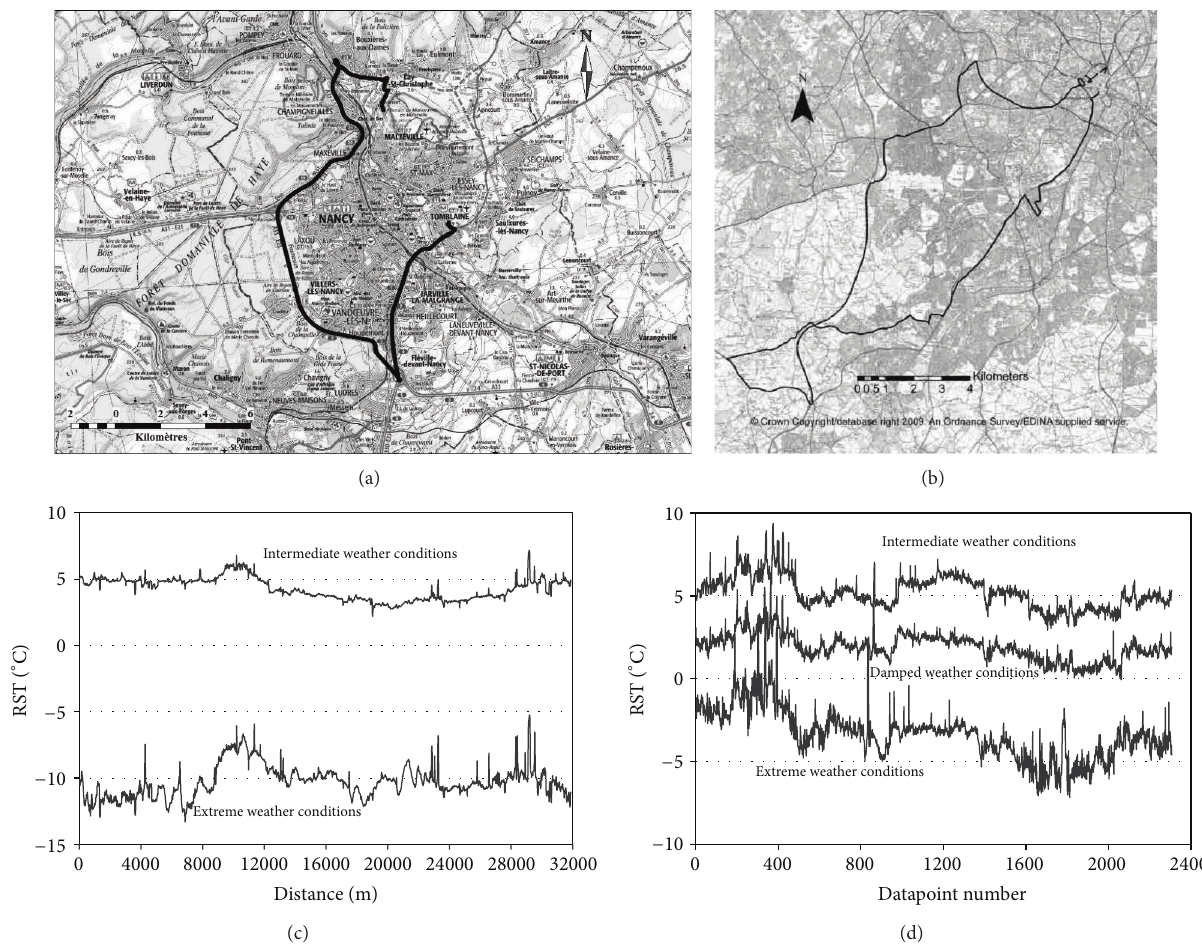
Figure 1: Thermal mapping routes in France (a) and United Kingdom (b) and associated thermal fingerprints for French (c) and United Kingdom (d) routes.